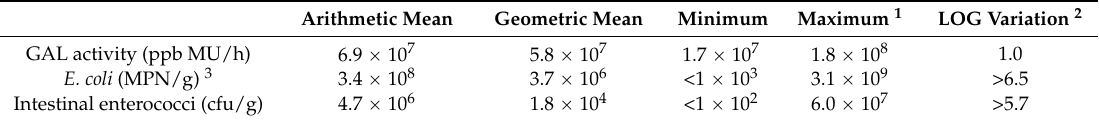
Table 3. GAL activity and fecal indicator bacteria in samples of human feces (total of 14 samples from 8 individuals).